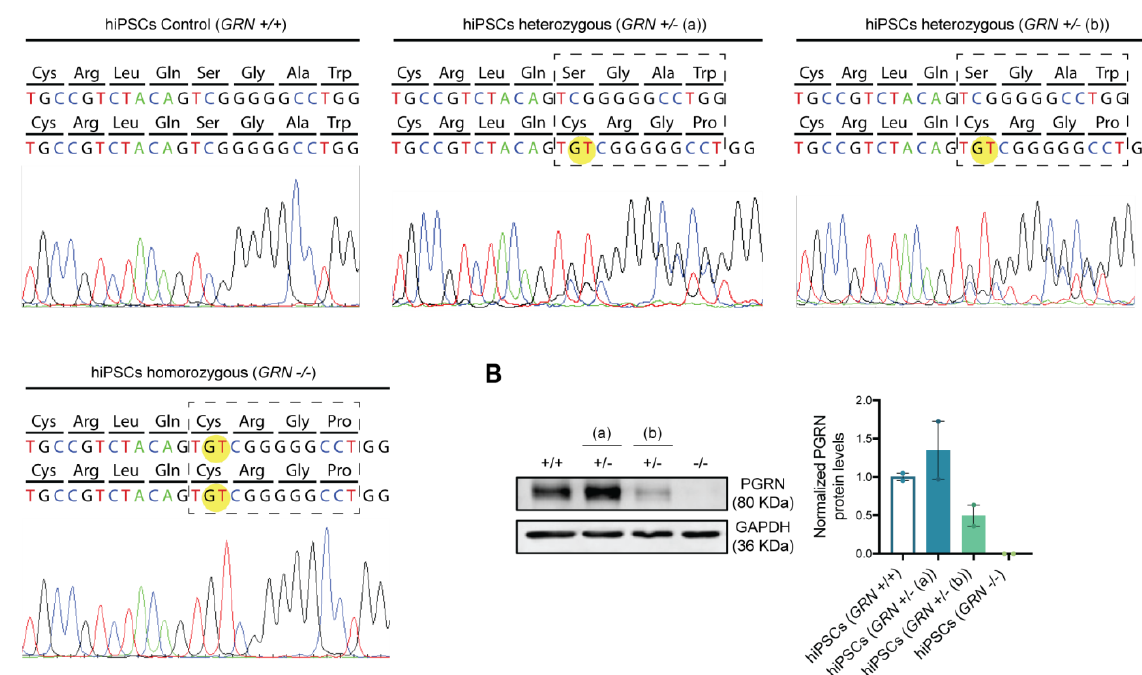
Figure 3. FTLD patient-derived hiPSCs present different progranulin genotypes . After reprogram- ming, DNA sequencing and protein expression of the newly established hiPSC lines from the three different individuals were assessed and the presence of progranulin mutation c.900_901dupGT was confirmed in all colonies generated from each of the three individuals. ( A ) Electropherogram of the regions containing the studied mutation in the generated hiPSCs shows the GT duplication in one allele from the patient harboring the heterozygous mutation and in both alleles from the patient harboring the homozygous mutation. ( B ) Western blot quantification of PGRN protein levels was performed in the two most promising hiPSC colonies from each individual (described in Table 1). Representative Western blot membrane and quantification of PGRN band density levels, normal- ized to GAPDH, show a decrease in PGRN protein levels in both disease conditions ( GRN +/ − (b) and GRN − / − ), except for the asymptomatic heterozygous individual ( GRN +/ − (a)), which shows an increase in PGRN protein levels. Data are presented as mean ± s.e.m.